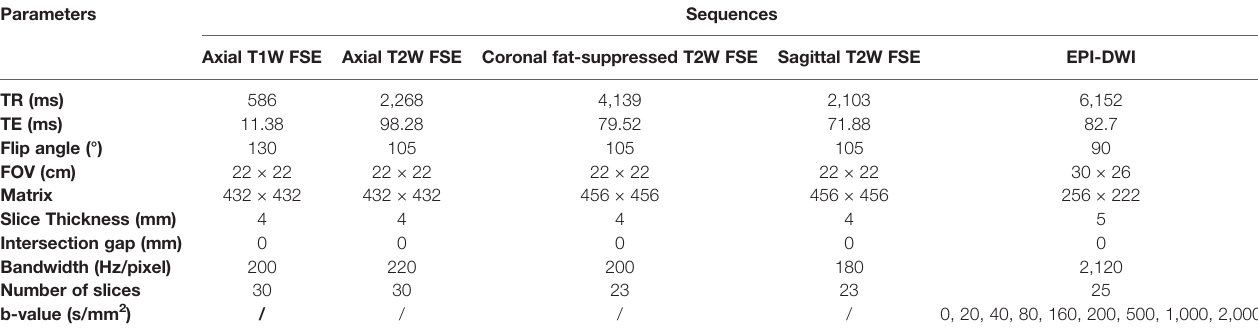
TABLE 1 | MRI protocols. Parameters Sequences